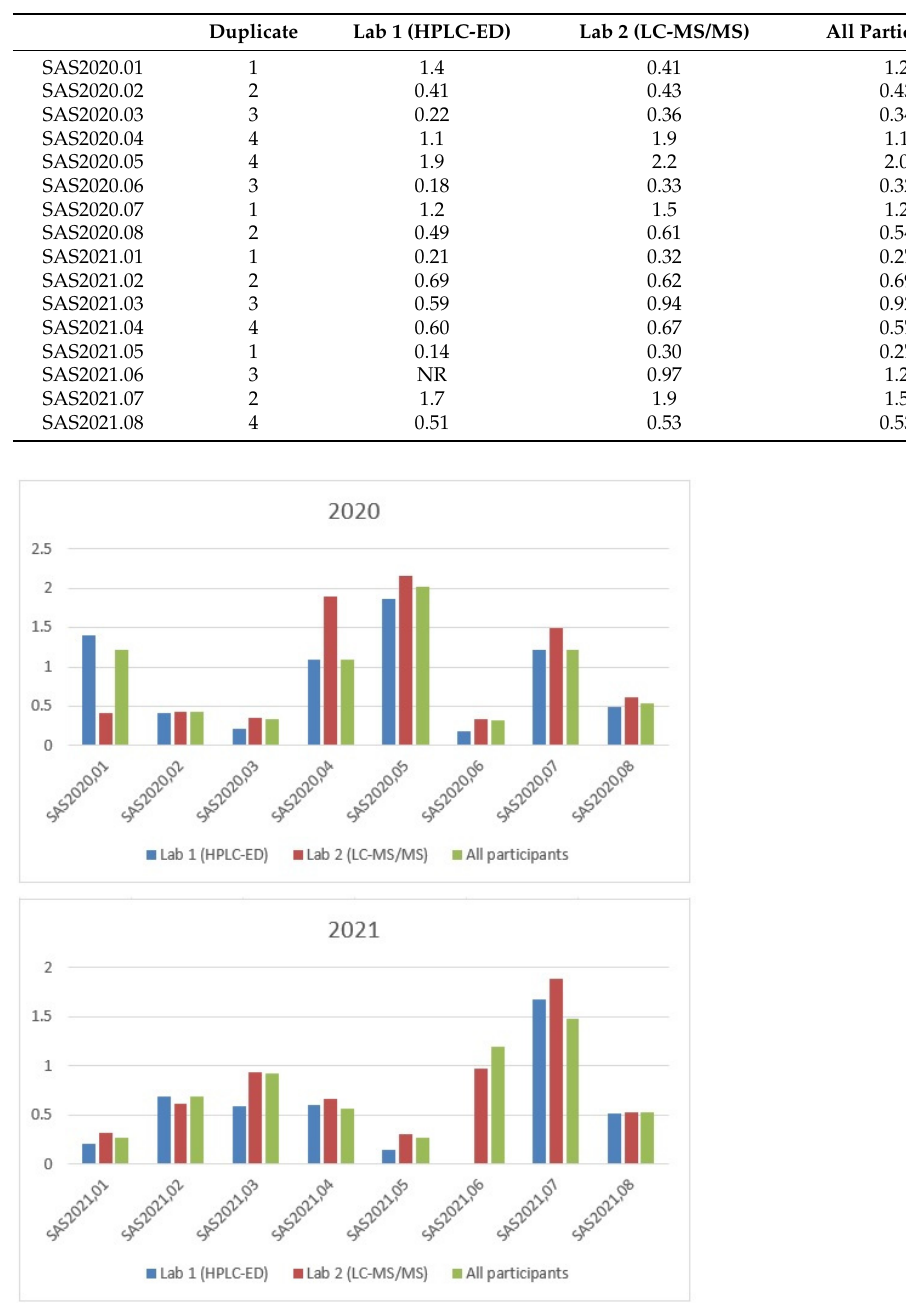
Table 3. Results of the EQC scheme obtained with the HPLC-ED (Lab 1) and LC-MS/MS (Lab 2) methods, and from all participants. Mean values are stated for (Lab 1) and (Lab 2), while median values are reported for all participants. All data are expressed in µ mol/L. Abbreviations: LC-MS/MS, liquid chromatography-tandem mass spectrometry; NR, not reported.